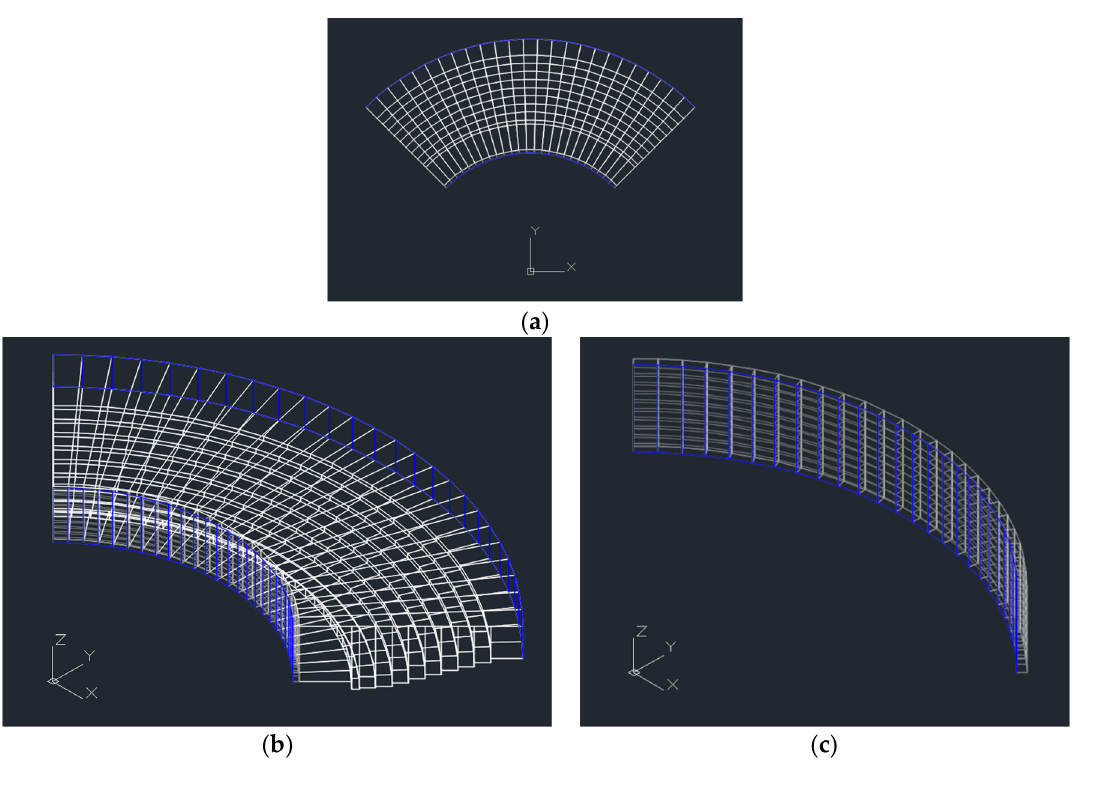
Figure 14. Virtual auditorium developed in the Case F. ( a ) Top view of the auditorium and the semi-circular DSF, ( b ) tri-dimensional southeast view of the auditorium and the semi-circular DSF, and ( c ) tri-dimensional southeast view of the semi-circular DSF.